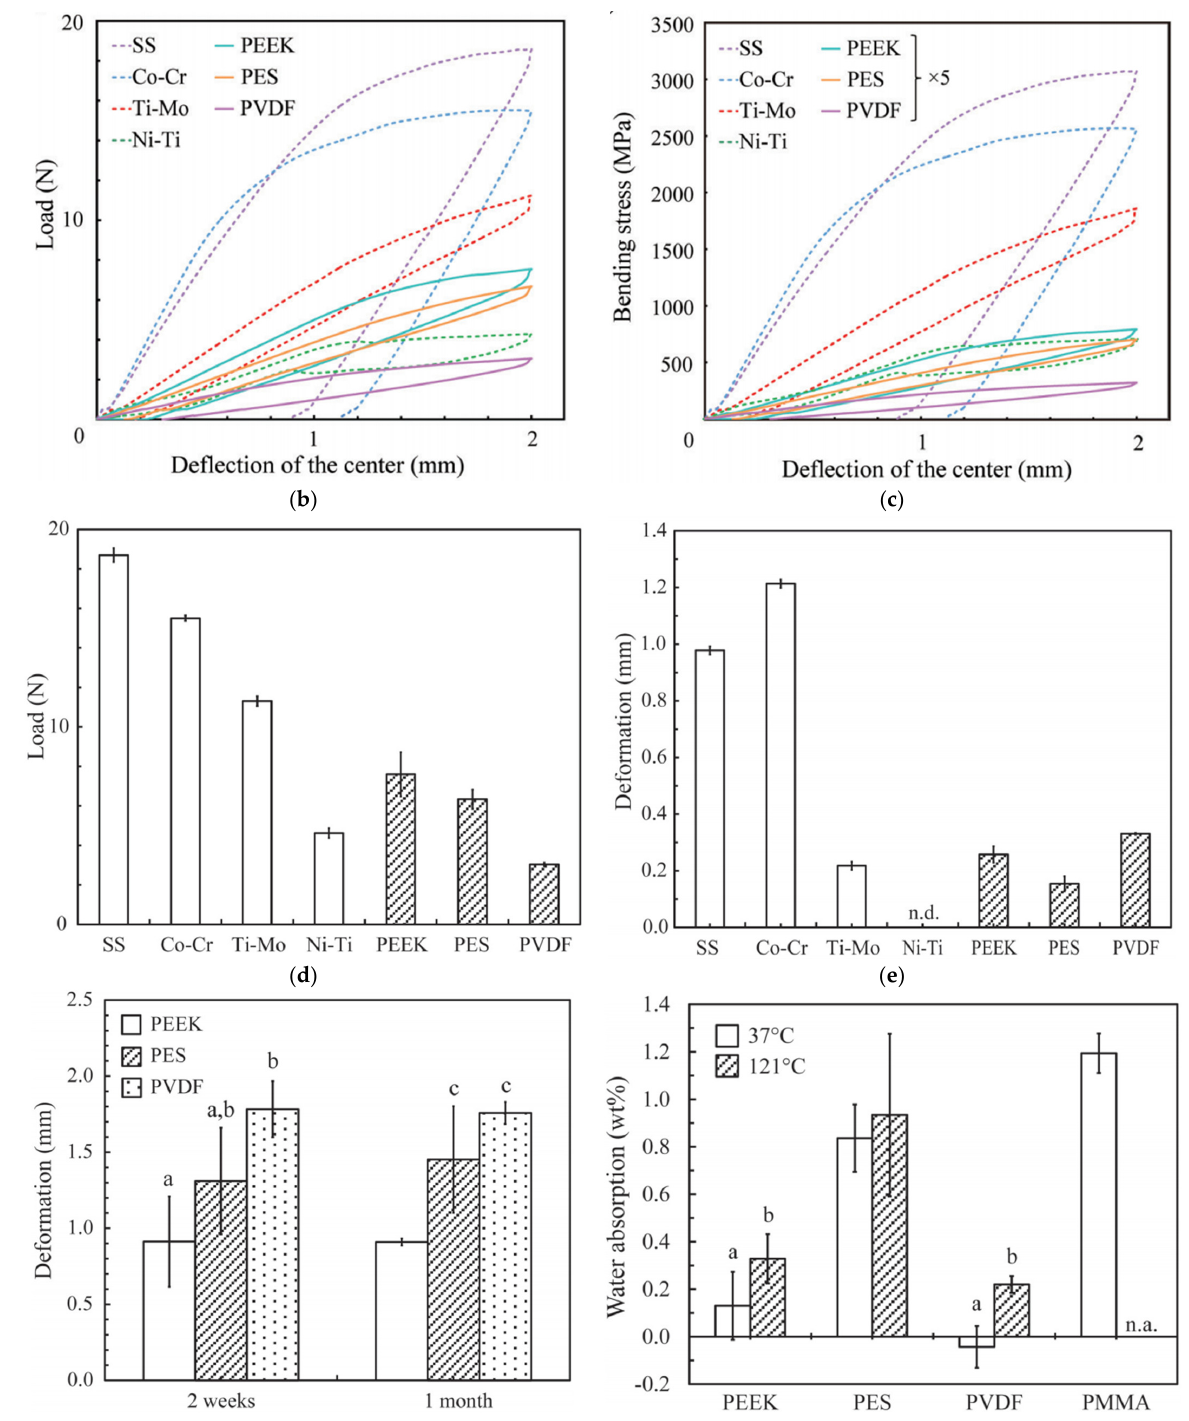
Figure 2. Mechanical properties of PEEK orthodontic wires. ( a ) Color properties of SEPs (1.0 mm thick). Curves of load-deflection ( b ) and bending stress-deflection ( c ) for the specimens via the three-point bending test. ( d ) Bending load at 2.0 mm deflection and ( e ) permanent deformation after three-point bending test. Data are mean ± SD from five independent replicates. Tukey-Kramer HSD test indicated significant differences between each pair ( p < 0.05). ‘n.d.’ means ‘not detected’. ( f ) Permanent deformation after 2.0 mm bending creep test (for 2 weeks and 1 month). ( g ) Water absorption at 37 and 121 ◦ C (autoclaving) for 10 days. Data are mean ± SD from four independent replicates. ‘n.a.’ means ‘not available’. Bars annotated with the same letter are not significantly different, as assessed by Tukey-Kramer HSD test ( p > 0.05). (Reproduced from [17], with permission from © 2015